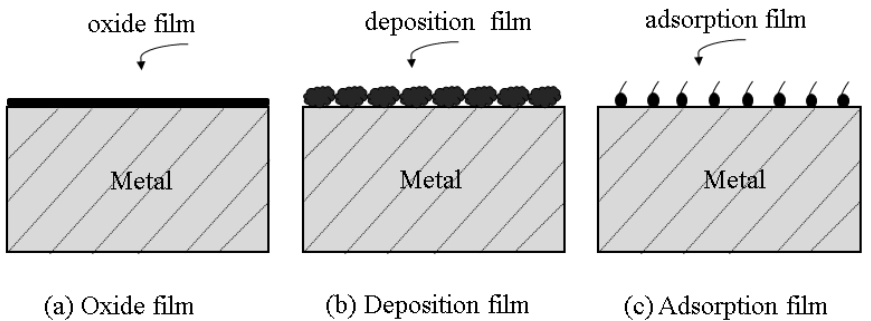
Figure 4. Adsorption diagram of ( a ) oxide film, ( b ) deposition film, and ( c ) adsorption film.